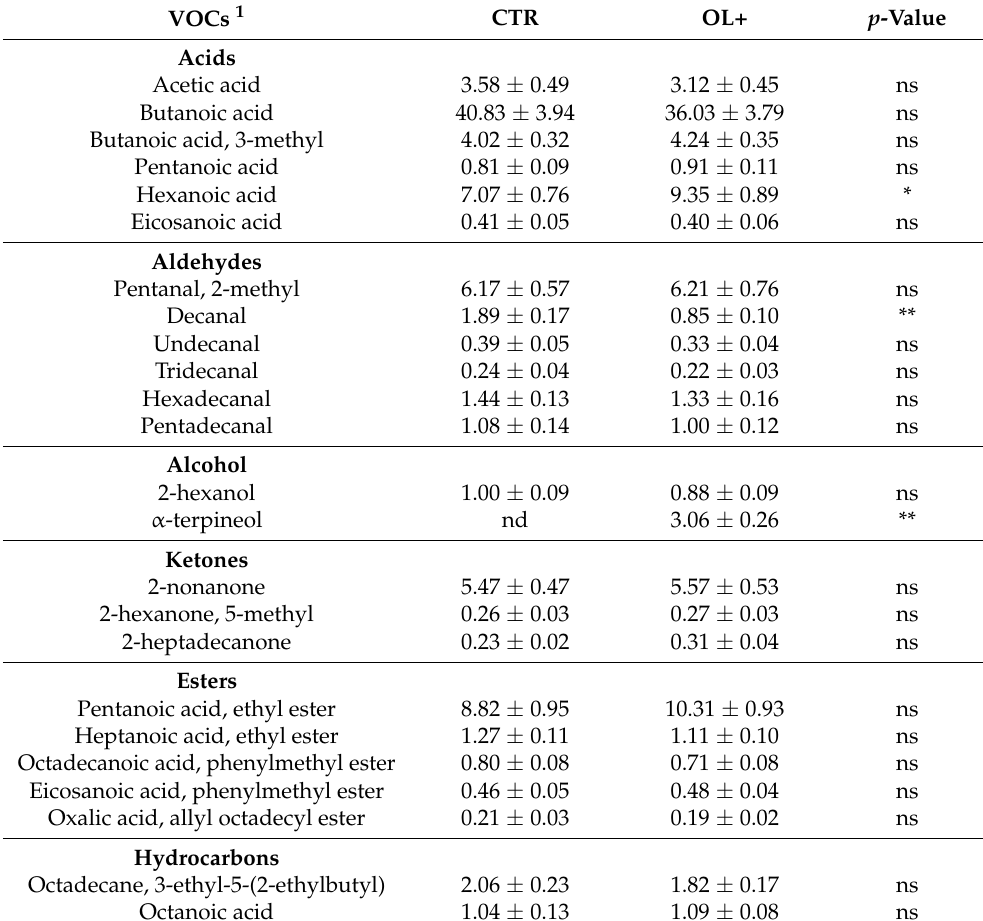
Table 5. Volatile compounds (VOCs) detected in rumen samples obtained from goat kids fed a standard diet (CTR) and animals fed a dietary supplementation with olive leaves